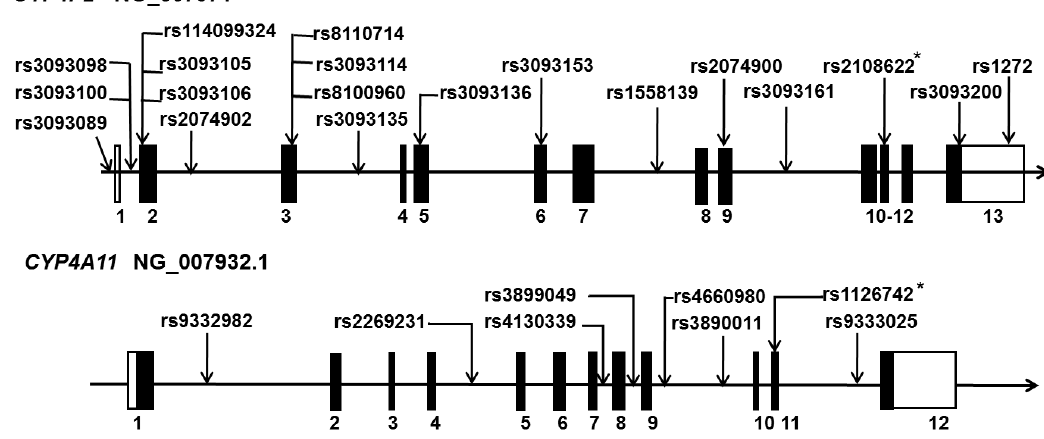
Figure 1. Genetic polymorphisms in human CYP4F2 and CYP4A11 . Localization of single nucleotide polymorphisms (SNPs) in genomic DNA of CYP4F2 (upper panel, NG_007971) and CYP4A11 (lower panel, NG_007932.1). Numbers indicate the order of exons. Solid portions of exons indicate transcription regions. Open frames on exons indicate non-transcription regions of CYP4F2 and CYP4A11 . Published RefSNPs (rs) numbers linked with hypertension and stroke are listed. Asterisks (*) indicate that the SNPs are also associated with other diseases, including cardiovascular disease and kidney transplantation.